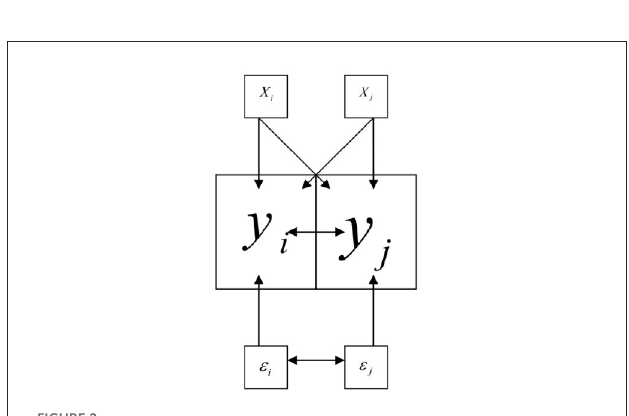
FIGURE2 The figure shows the scheme of the spatial lag model (Catma,